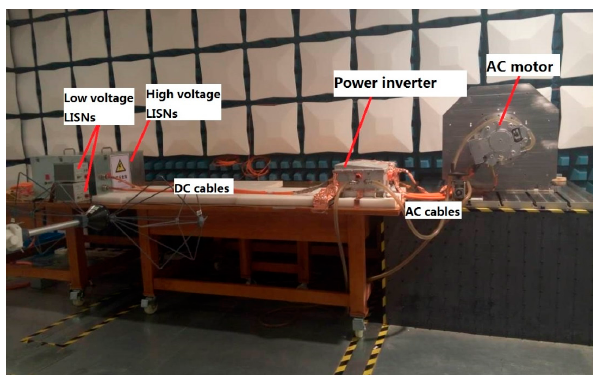
Figure 2. The test platform for conducted EMI emission.